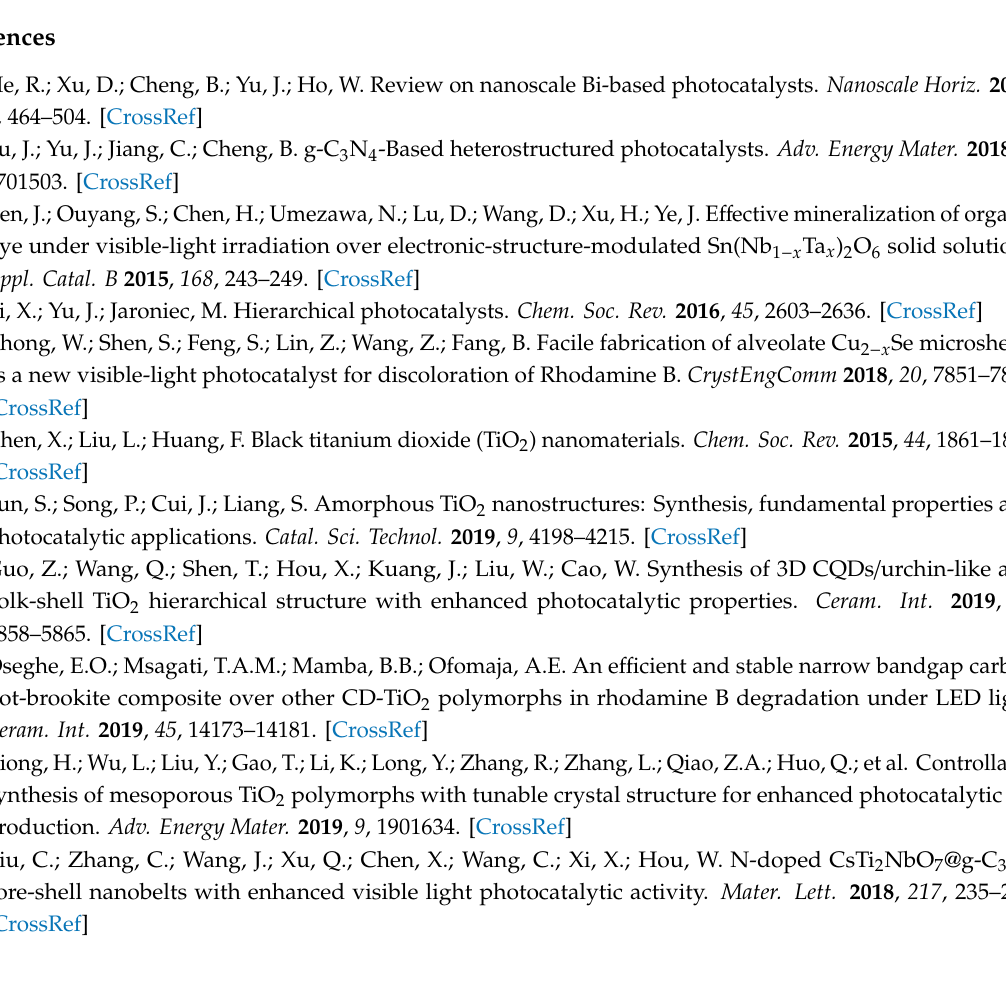
Supplementary Materials: The following are available online at http: // www.mdpi.com / 2079-4991 / 9 / 10 / 1503 / s1, Figure S1. (a) ( α hv)2 versus photo energy (hv) and (b) VB-XPS spectrum of pure K3Ti5NbO14. Figure S2. High-resolution XPS spectra for STNT3: (a) C 1s spectrum, and (b) N 1s spectrum. Figure S3. Visible-light-driven photocatalytic degradation rate of methylene blue (MB) solution over K3Ti5NbO14, S-TiO2 and STNT3. Table S1. Summary of optical power and power density. Table S2. Summary of elemental contents for